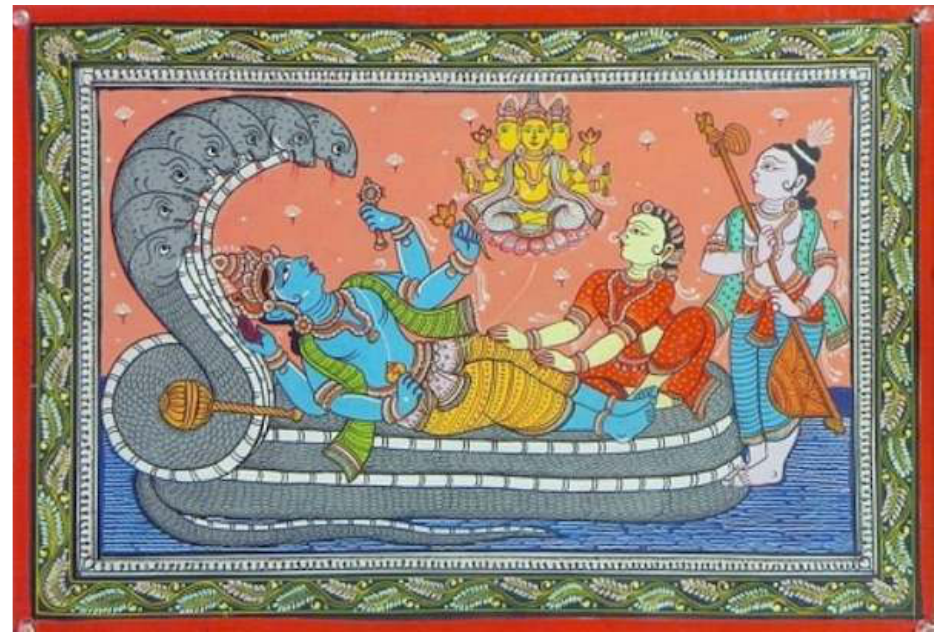
Source: Orissa State Museum,